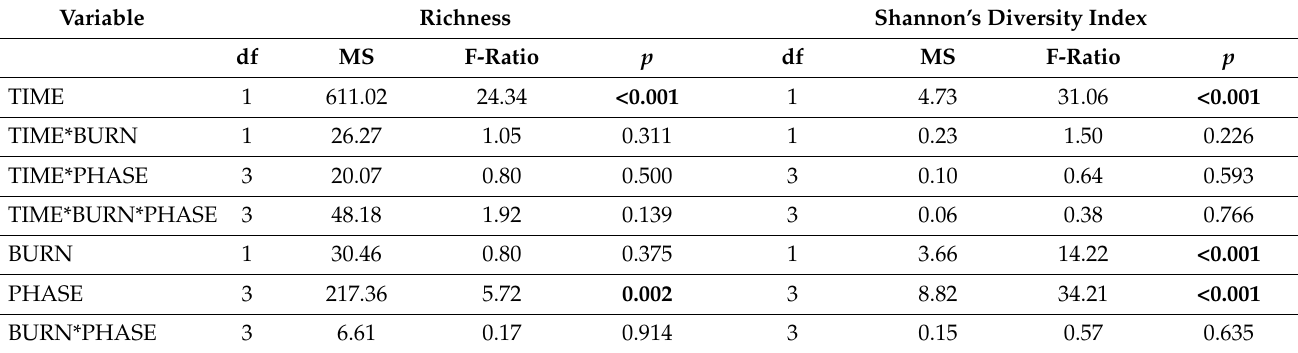
Table 1. Evaluation of changes in species richness per plot and Shannon’s Diversity Index by sampling period (TIME; repeated measure), pre-fire woodland development phase (PHASE) and fire (BURN) and their interactions were conducted with a three-way repeated-measures ANOVA (df—degrees of freedom; MS—mean squares; F-ratio and p -value). Significant relationships ( p < 0.05) are in bold